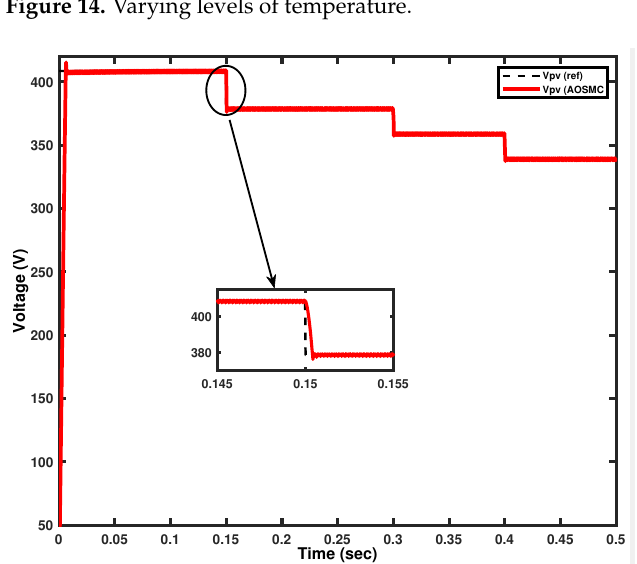
Figure 14. Varying levels of temperature.